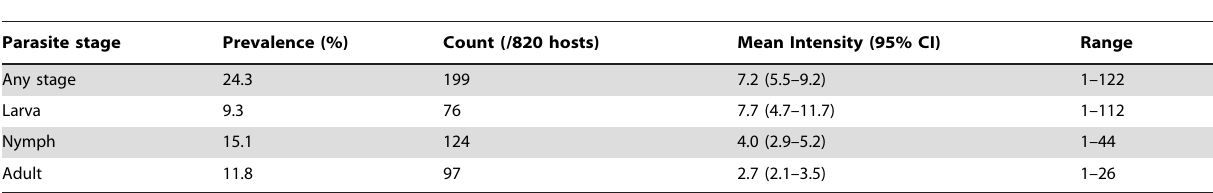
Table 1. Summary of Ixodes hexagonus on